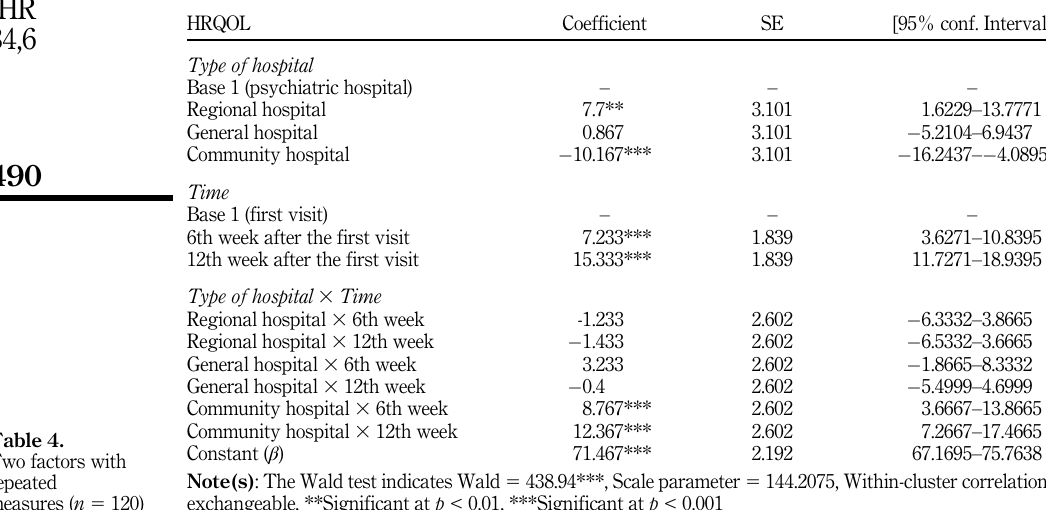
repeated measures ( n 5